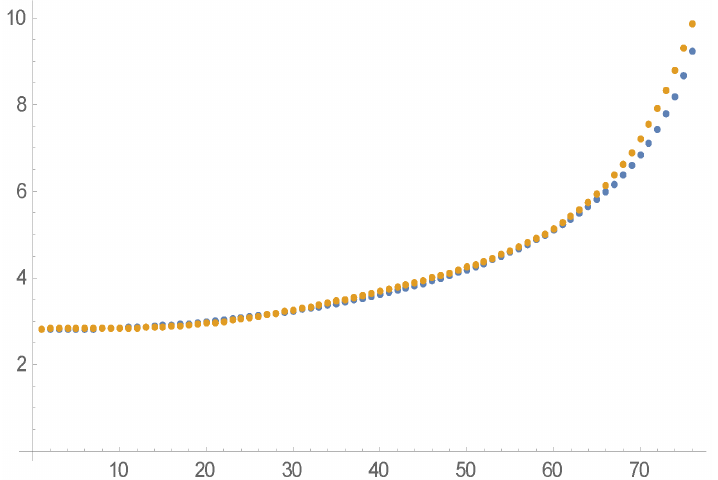
Figure 8. Comparison between approximated (orange line) and real data (blue line) in the inter- val ( 0.2,1 )